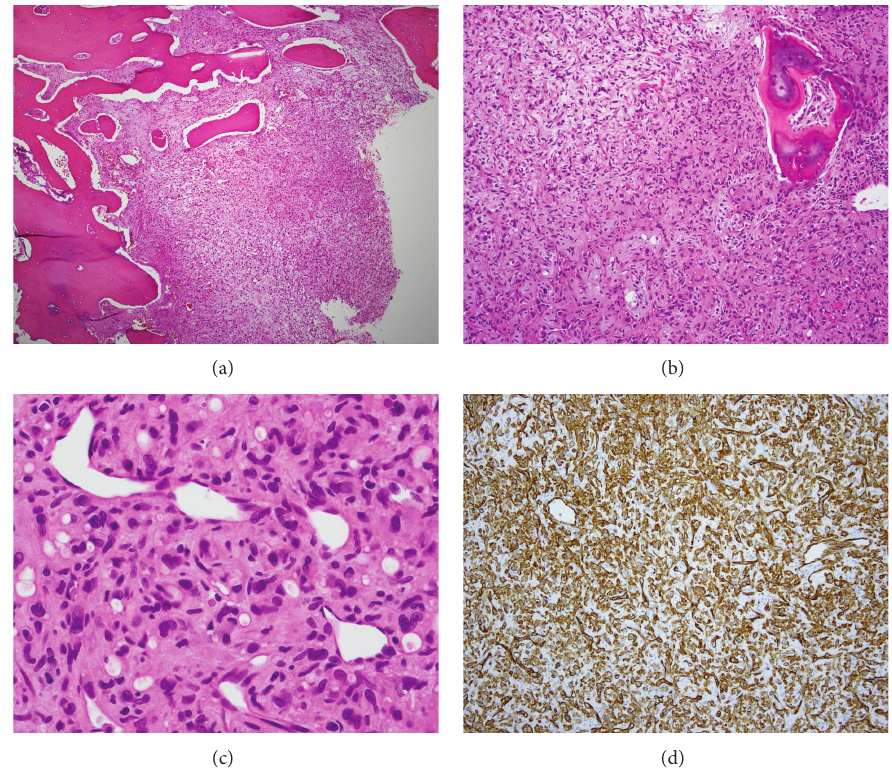
F 3: Epithelioid hemangioendothelioma involving the mastoid bone ((a) H&E